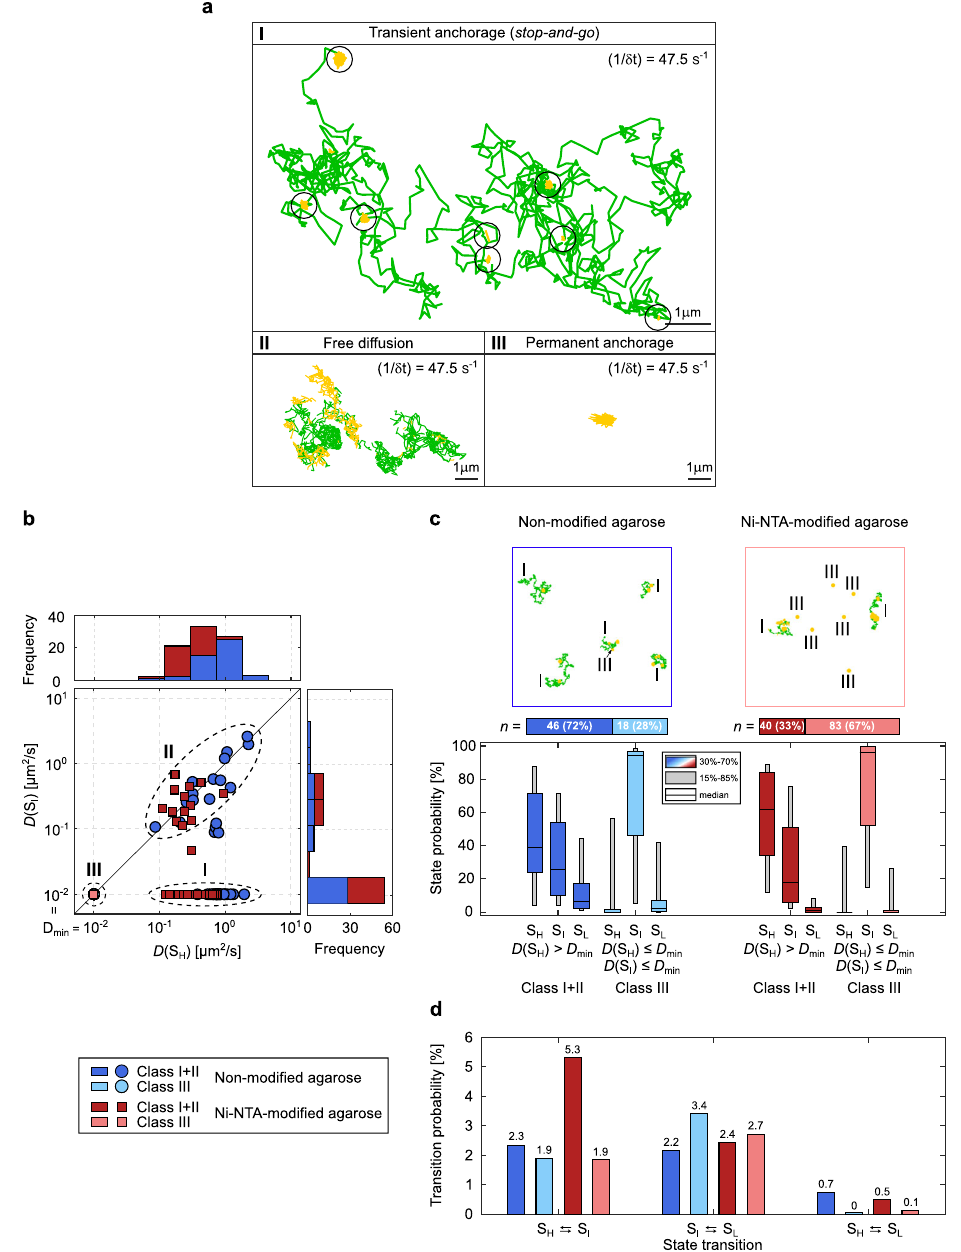
Fig. 5 Statistical correlation between channel activity and lateral mobility of TOM-CC. a Trajectories for various modes of TOM-CC mobility. Class I, diffusion interrupted by periods of transient anchorage (sites of transient anchorage circled); Class II, free diffusion; Class III, permanent anchorage. Moving particles in S H are shown in the trajectories in green; transiently or permanently tethered molecules in S I are shown in yellow. Data were acquired for t = 60 s at a frame rate of 47.5 s − 1 . b D (S I ) as a function of D (S H ) individually plotted for all TOM-CC molecules in DIB membranes supported by non- (cid:1) (cid:3) (cid:1) (cid:3) modi fi ed (dark blue and light blue, n = 64) and Ni-NTA modi fi ed agarose (dark red and light red, n = 123). Frequency histograms of D (S I ), D S and D S H I are shown on top and right side, respectively. Three classes can be de fi ned: a main class (I) of moving particles in S H while being transiently tethered at S I (cid:4) (cid:4) (cid:1) (cid:3) (cid:1) (cid:3) (cid:5)(cid:6) (cid:1) (cid:3) (cid:1) (cid:3) (cid:5)(cid:6) (cid:4) \ D S (cid:4) \ D S (cid:2) D , a second class (II) of freely moving particles in S H and S I II D S and a third class (III) of I D S > D min > D min > D min (cid:4) (cid:1) (cid:3) (cid:1) (cid:3) (cid:5)(cid:6) H I min H I (cid:4) \ D S permanently tethered molecules in S I and S L III D S H (cid:2) D min (cid:2) D min . c Example trajectories (top and Supplementary Movie S7) and state I probabilities (bottom) of non-permanently and permanently tethered TOM-CC in DIBs supported by non-modi fi ed and Ni-NTA-modi fi ed agarose. The probability of being in state S H is higher for non-permanently (classes I and II, dark blue [ n = 46] and dark red [ n = 40]) than for permanently tethered molecules (class III, light blue [ n = 18] and light red [ n = 83]). The probability of being in state S I is signi fi cantly higher for permanently (class III) than for non-permanently tethered particles (classes I and II). This suggests that binding of Tom22 to Ni-NTA agarose below the membrane triggers closure of the TOM-CC channels. The data are represented as median; the con fi dence intervals are given between 15 to 85% and 30 to 70%. d Absolute state transition probabilities classi fi ed by bidirectional state transitions as S H ⇆ S I , S I ⇆ S L , and S H ⇆ S L . Diffusive TOM-CC molecules have a signi fi cantly higher transition probability for switching between S H and S I in DIBs supported by Ni-NTA-modi fi ed agarose (~5.3%) than in non-modi fi ed agarose membranes (~2.3%). This is consistent with the higher ef fi cacy of TOM-CC-trapping by Ni-NTA-modi fi ed agarose compared to non-modi fi ed agarose. Classi fi cation of non- permanently and permanently tethered TOM-CC is shown at the left